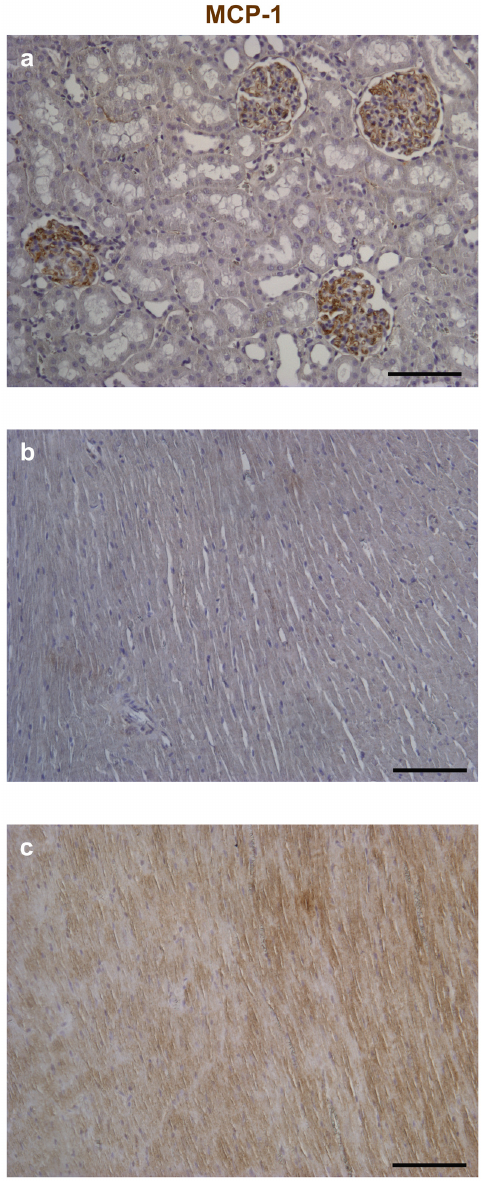
Figure 4. Immunohistochemical analysis of Monocyte Chemoattractant Protein ‐ 1 (MCP ‐ 1). Reference tissues for the detection of MCP ‐ 1 by immunoperoxidase (brownish) were represented by the rat kidney ( a ); Compared to control ( b ); Higher expression of the chemokine is apparent in both cardiomyocytes and interstitial cells of the diabetic left ventricular (LV) myocardium ( c ). Nuclei were counterstained by Hematoxylin. Scale bars: 100 μ m.